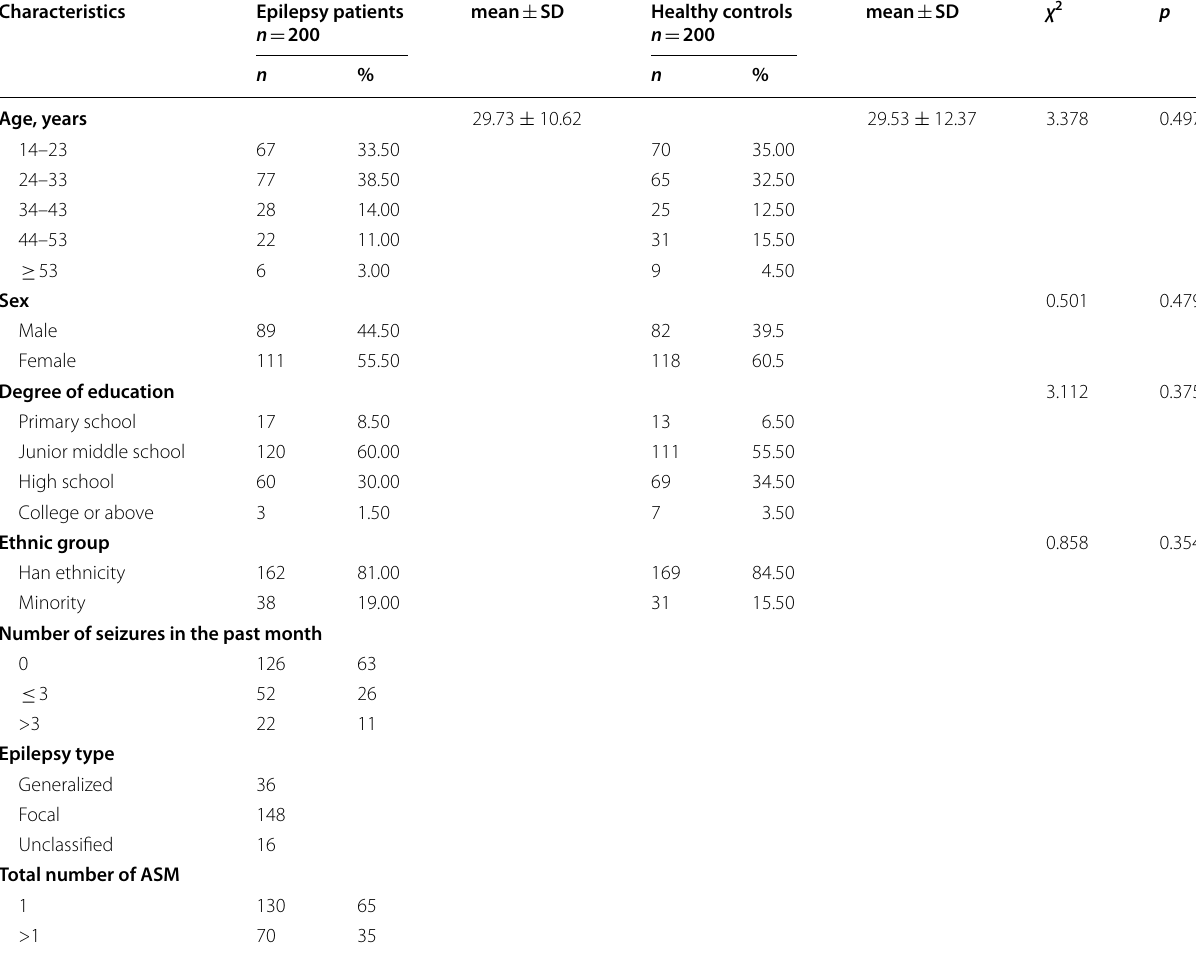
Table 1 Clinical and demographic characteristics of participants Characteristics